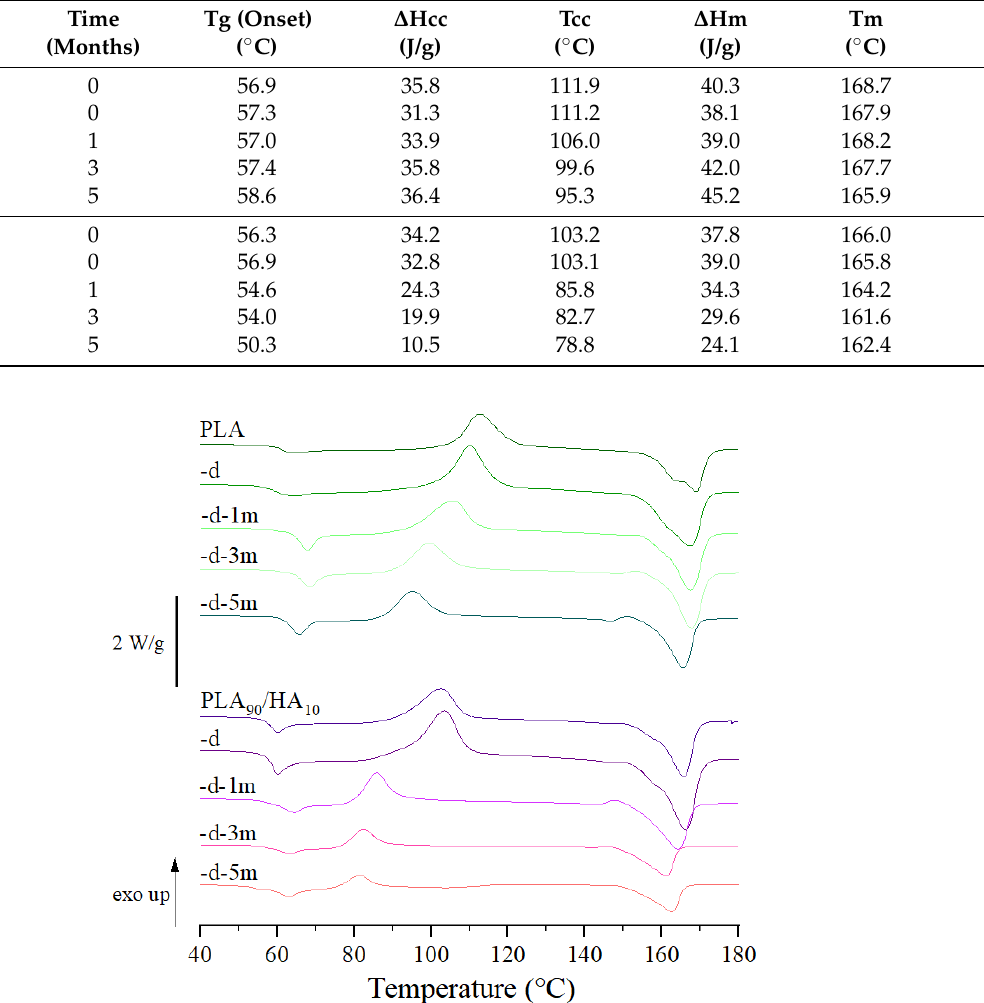
Table 2. Onset glass transition temperature (Tg(onset)), cold crystallization enthalpy ( ∆ Hcc), cold